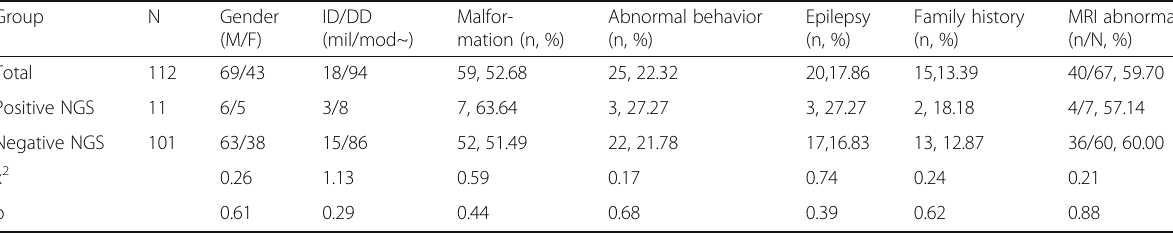
Table 1 Clinical characteristics of 112 ID/DD patients